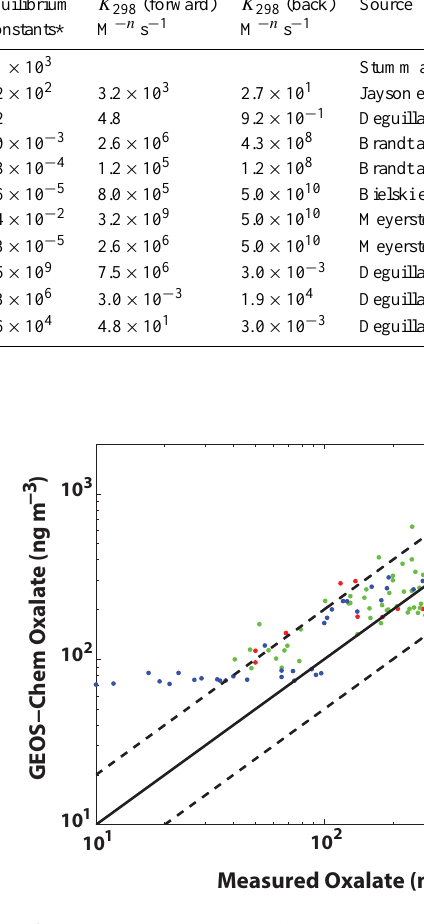
Fig. 2. Model-predicted surface level oxalate concentrations rela- tive to measurements conducted in urban (red dots), rural (green), and remote oceanic (blue) regions. Observed surface level oxalate concentrations are taken from Myriokefalitakis et al. (2011) and ref- erences within. The solid black line illustrates the 1 : 1 comparison, and the two dashed lines are the 1 : 2 and 2 : 1